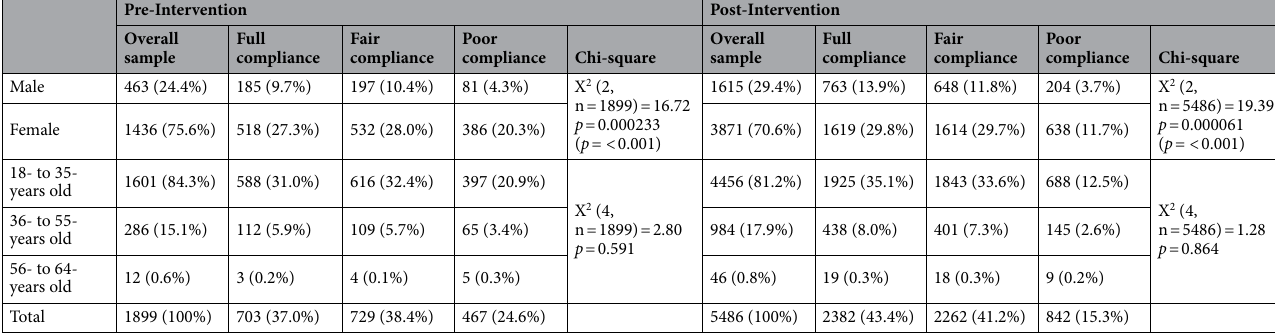
Table 2. Compliance in the pre-and post-intervention cohorts, stratified by age group and by gender. A Chi- square test was used to test for differences in the strata in each